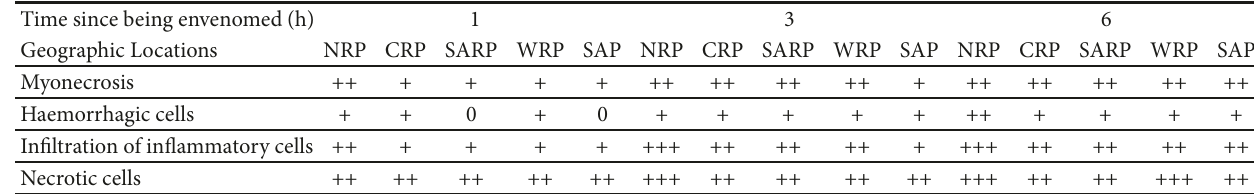
Table 1: Major histopathological changes in skeletal muscles induced by N. naja venom from distinct geographic origins in Sri Lanka. Score: 0: absent; +: mild; ++; moderate; and +++: severe [45]. Time since being envenomed (h) 1 3 6